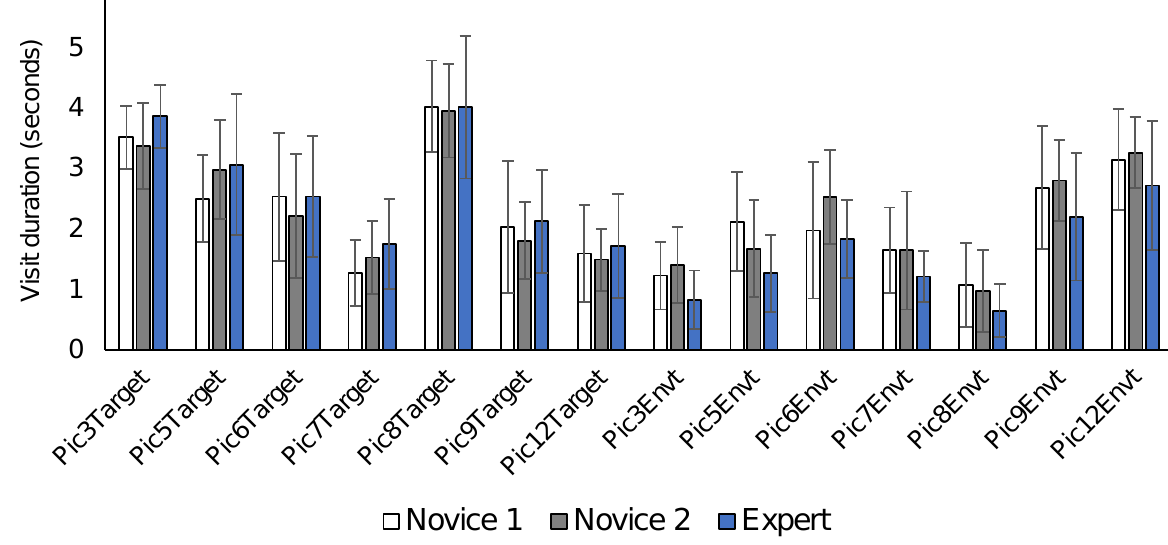
Figure 4. Visit duration for target versus environment areas of interest for seven individual images (see Supplementary Materials).